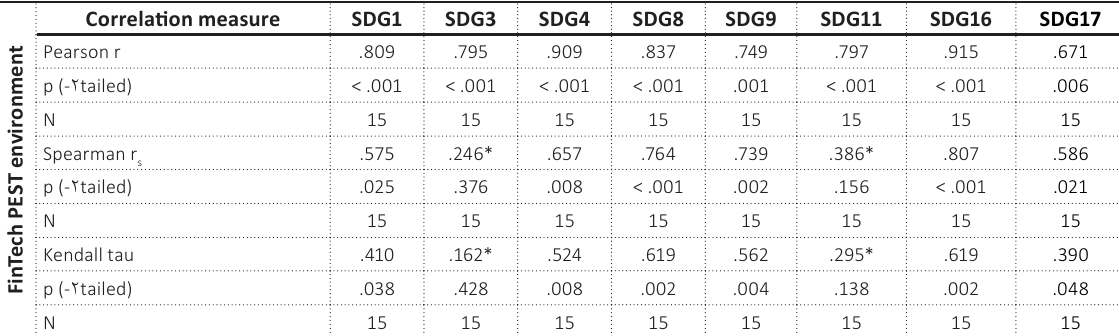
Table 7. Kendall, Pearson, and Spearman correlation coefficients measuring the strength of association between FinTech PEST environment and